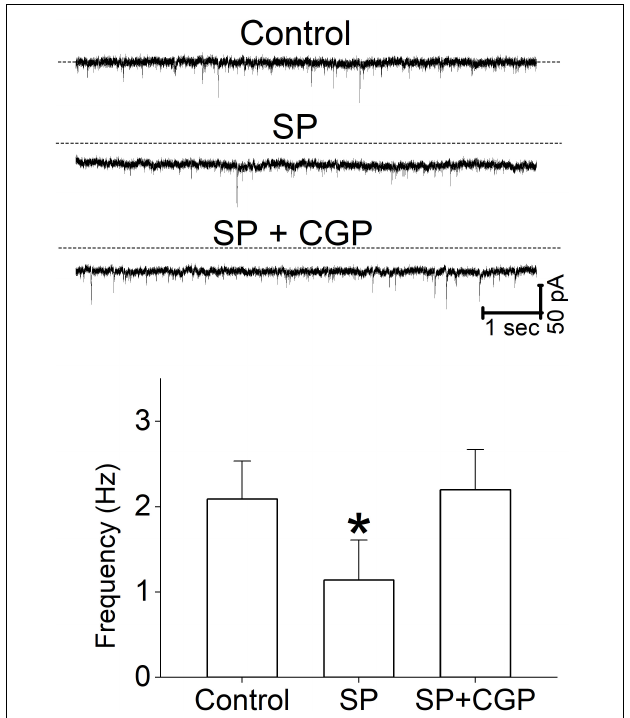
FIGURE 8 | The effect of a GABA B receptor antagonist on sEPSC frequency. Representative current traces from a single neuron show the effect of SP (1 µ M) and CGP (5 µ M) on sEPSCs. The sEPSC frequency data were obtained from 5 different neurons. All columns and error bars indicate the mean ± SDM, * P <